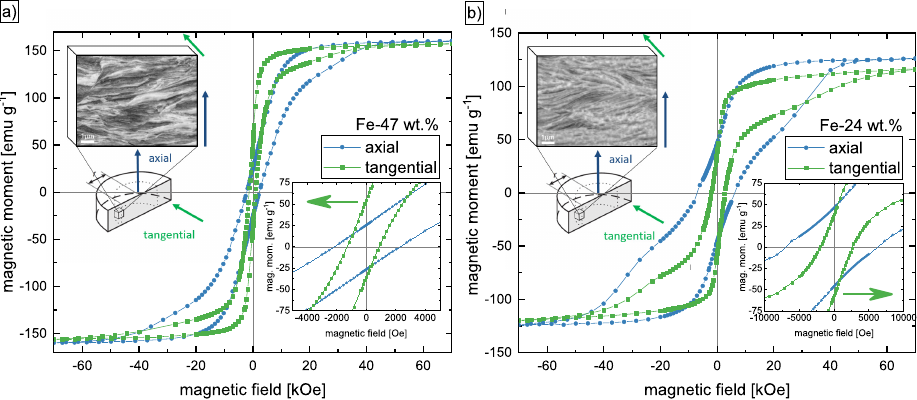
Figure 7. Hysteresis loops measured at 8 K in axial and tangential direction for Fe-SmCo 5 samples with ( a ) 24 and ( b ) 47 wt.% Fe content. The inset shows the direction of the applied magnetic field compared to the